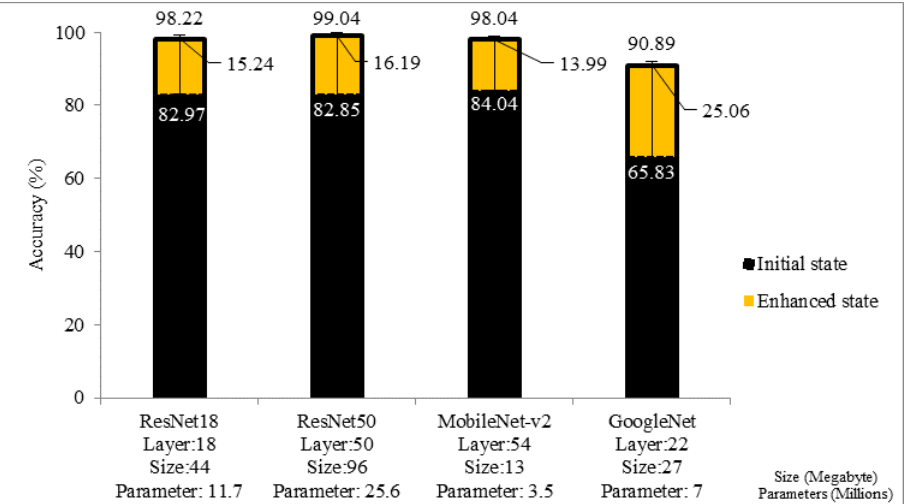
Figure 3. Comparison of CNN architectures in terms of accuracy in initial and enhanced status in the local datasets (HS-SS-PD combined).